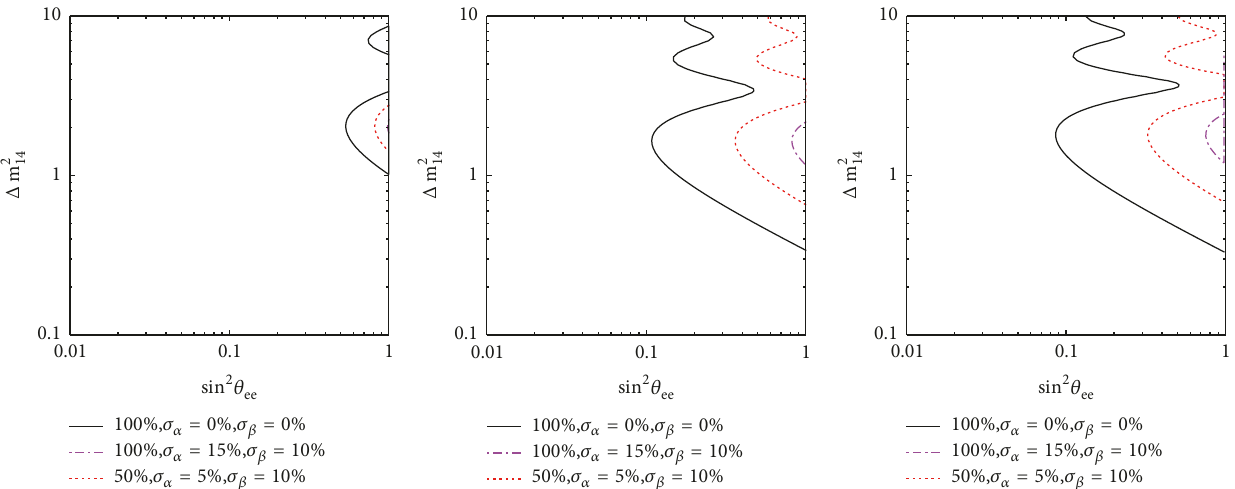
Figure 7: Expected sensitivity for an electron neutrino oscillation into a sterile neutrino state, for the different detectors under consideration: Germanium (left), Argon (middle), and NaI (right), respectively. Again, the different curves are for the ideal case of 𝜎 𝛼 = 0 % with 100 % efficiency and a background error of 𝜎 𝛽 = 0 % (solid), for 𝜎 𝛼 = 5 % with 50 % efficiency and a background error of 𝜎 𝛽 = 10 % (dotted), for 𝜎 = 15 % with 100 % efficiency and a background error of 𝜎 = 10 % (dashed-dotted), and 𝜎 = 30 % with 100 % efficiency and a background 𝛼 𝛽 𝛼 error of 𝜎 𝛽 = 10 % (dashed); see text for details. The horizontal line indicates the 90 %